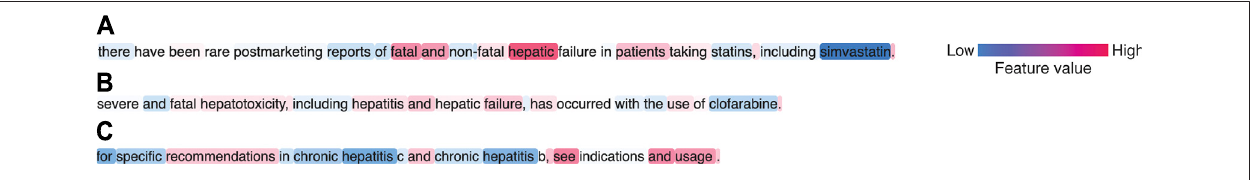
FIGURE 5 | Representative sentences showing contributions of word tokens to model predictions. (A) DILI-positive sentence due to fatal hepatic failure. (B) DILI- positive sentence due to hepatitis/hepatic failure. (C) DILI-negative sentence that provides indication